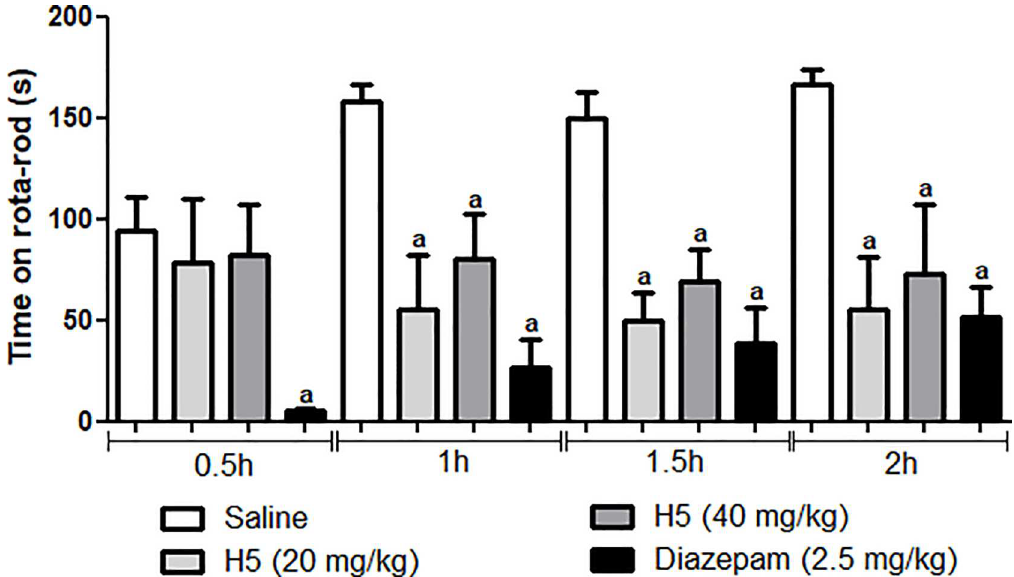
Fig 14. Effects of H5 (20 and 40 mg/kg, p.o.), and diazepam (2.5 mg/kg, i.p.) in the Rota-rod test in mice. Values are expressed as mean ± S.E.M. (n = 6, per group), where a indicates p < 0.05, significantly different from the control group, according to ANOVA, followed by Tukey’s post-test.